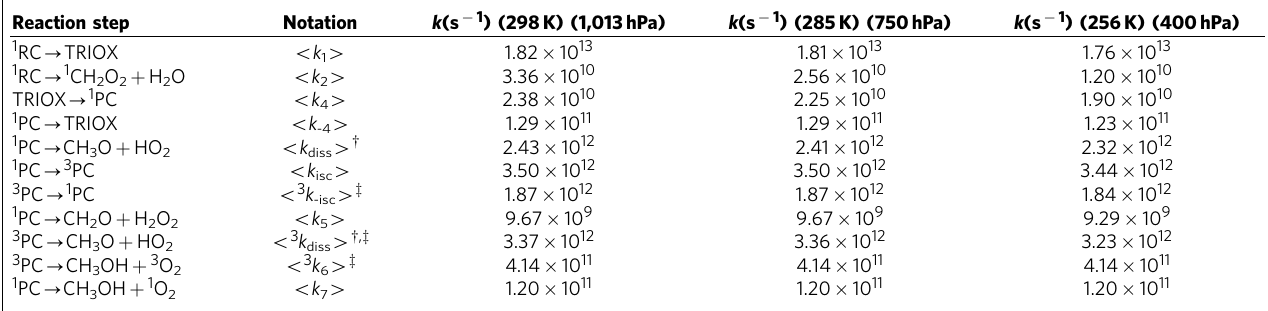
Table 2 | RRKM-calculated rate coefficients o k ( E v ) 4 averaged over the thermal energy distribution of formation F ( E th,v )* for the various chemically activated reactions.